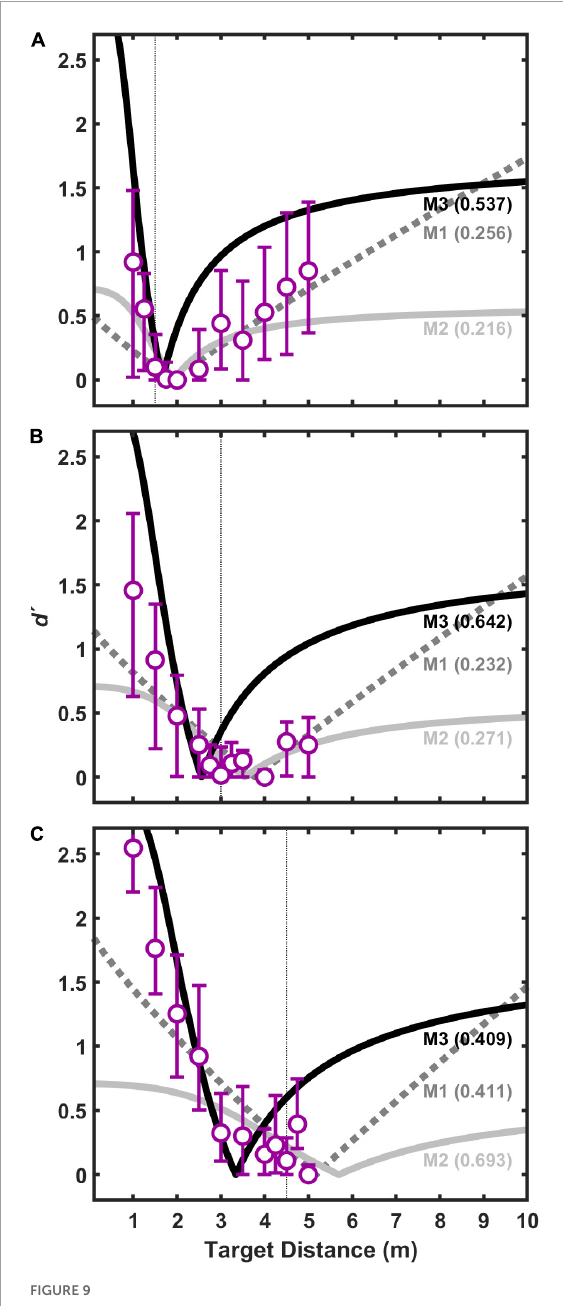
FIGURE9 Same (pooled) data for visual target distances of 1.5 m (A) , 3.0 m (B) , and 4.5 m (C) as shown in Figure 5 , but fits displayed are for 1-parameter ( k aud ) models.